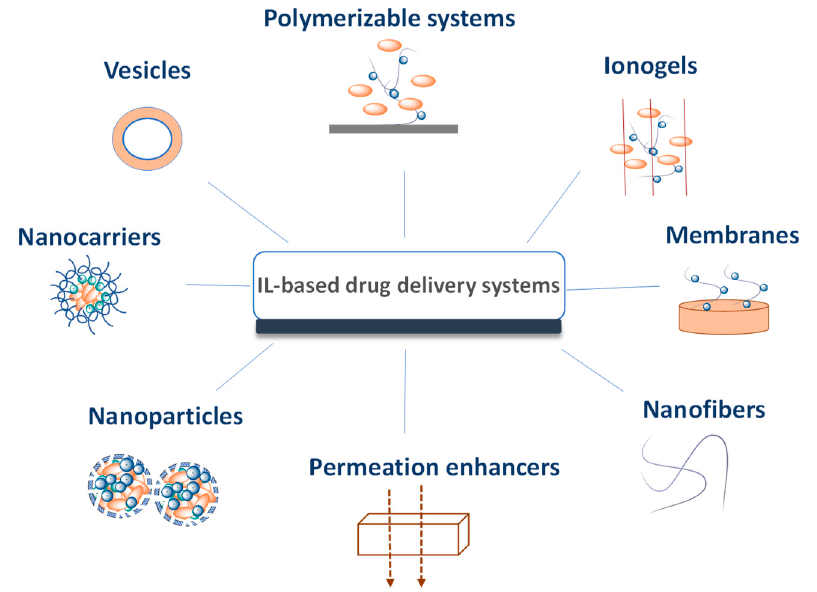
Figure 15. Schematic representation on the use of ILs in drug delivery systems (adequate references are given along the current section).